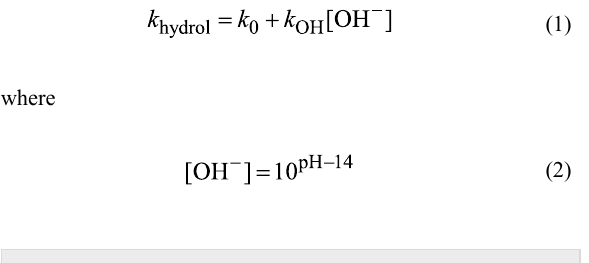
Table 1: Observed kinetic data for the hydrolysis of p -nitrophenyl ester 7 (R = p NP) a and m -nitrophenyl ester 7 (R = m NP) b at 25 °C.